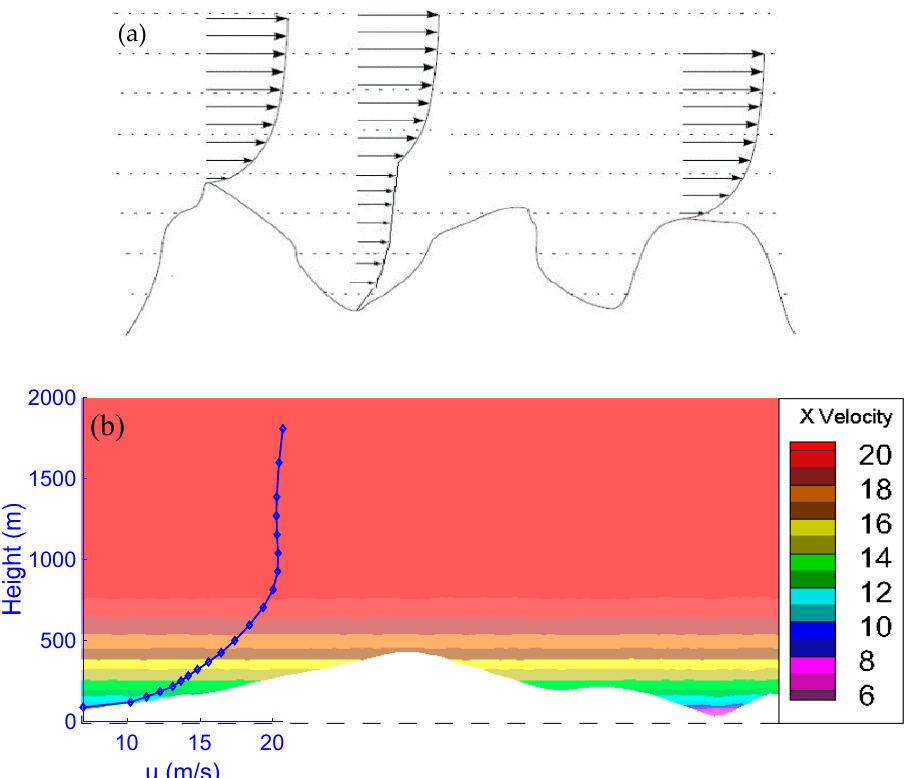
Figure 3. Extrapolation coupling method: ( a ) sketch map of extrapolation coupling on complex terrain; ( b ) the u component (m / s) of the CFD wind speed on the western boundary of the CFD domain. On the boundary, the horizontal axis represents width (0–4 km) of the CFD domain, and the vertical axis represents height (0–2 km). Using extrapolation, a single NWP profile (blue curve at 0 km on the horizontal axis) was extrapolated on the CFD boundary.